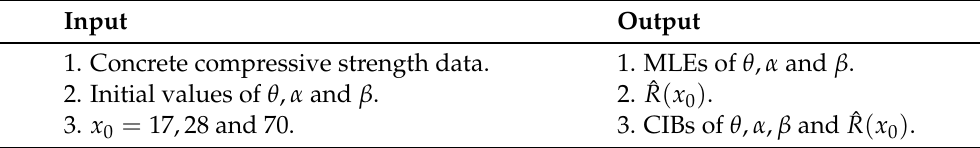
Table 9. Input and output values of the model for the concrete compressive strength